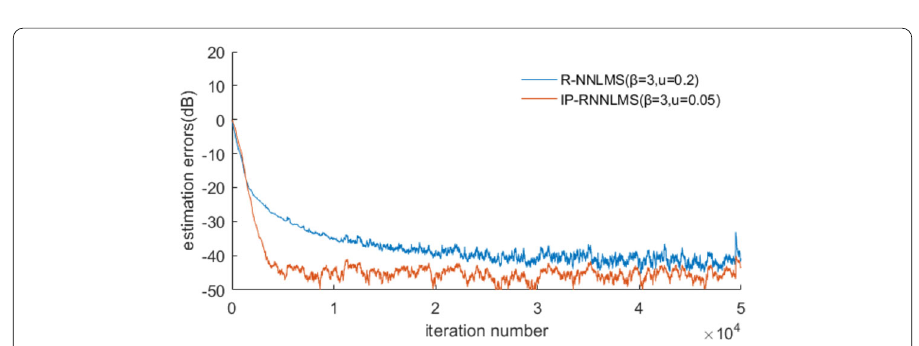
Figure 7 Estimated error of the IP-RNNLMS and R-NNLMS algorithms under impulsive noise (Pr( w = 0) = 0.5)